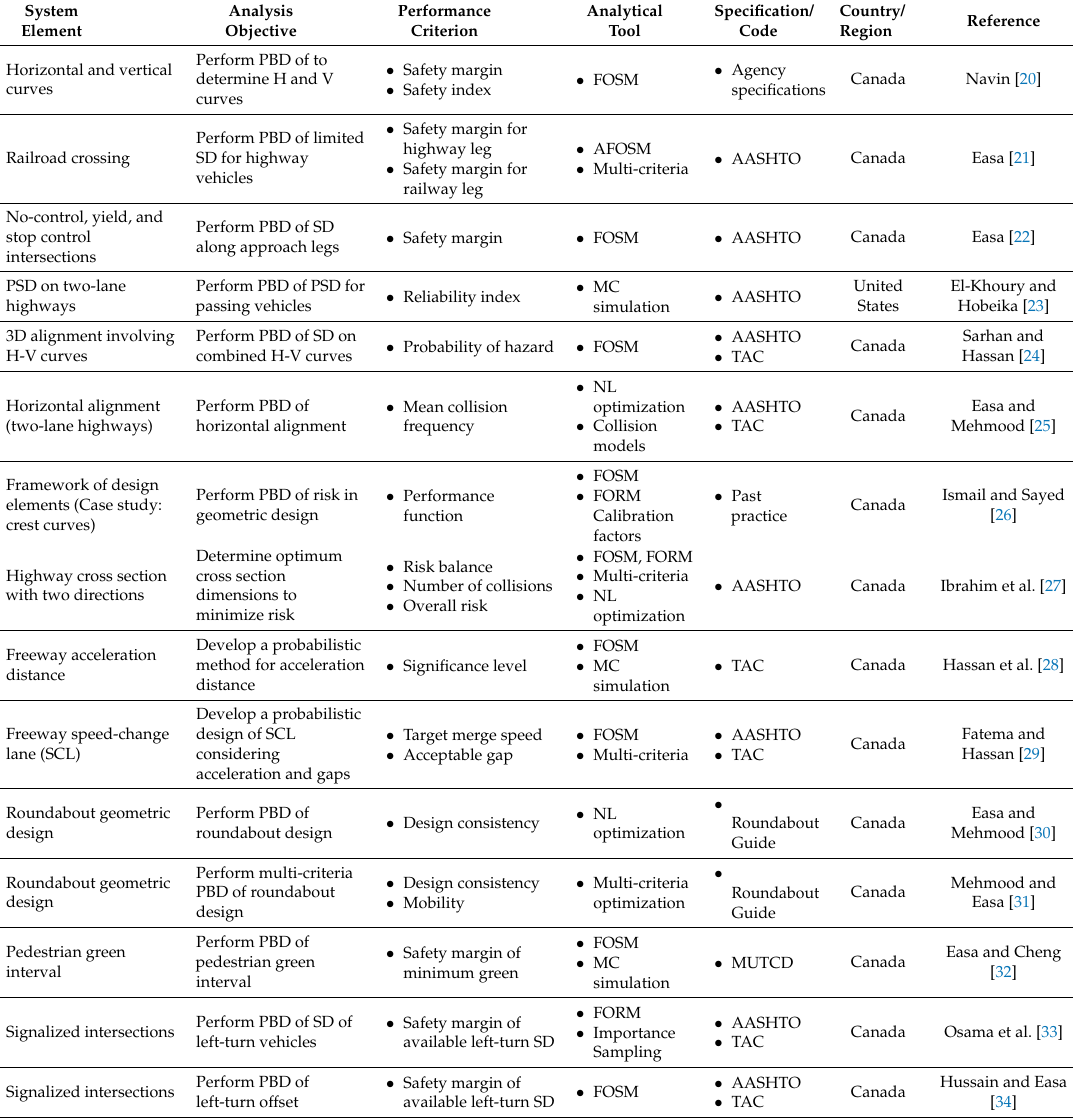
Table A1. Characteristics of highway transportation